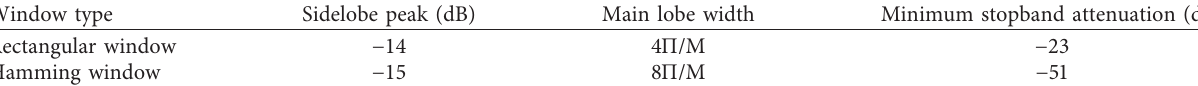
Table 1: Comparison of relevant indexes of rectangular window and Hamming window function.